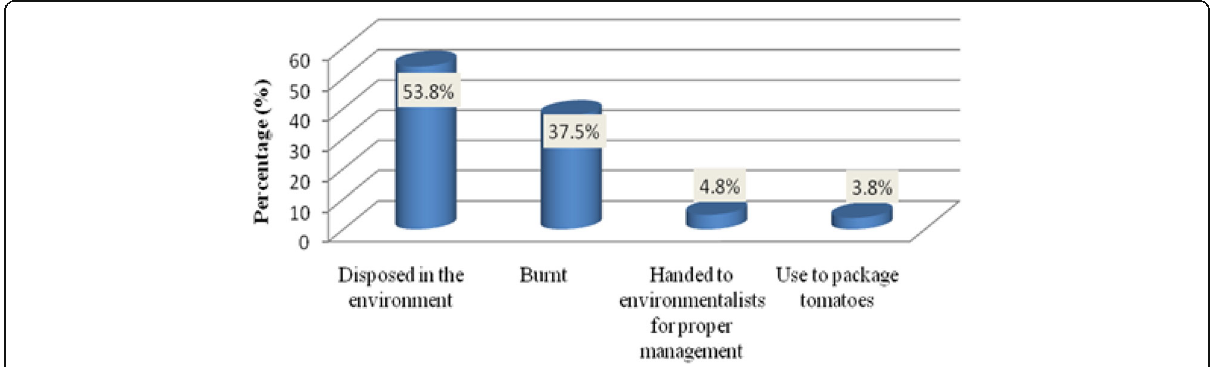
Fig. 1 The management of empty pesticide